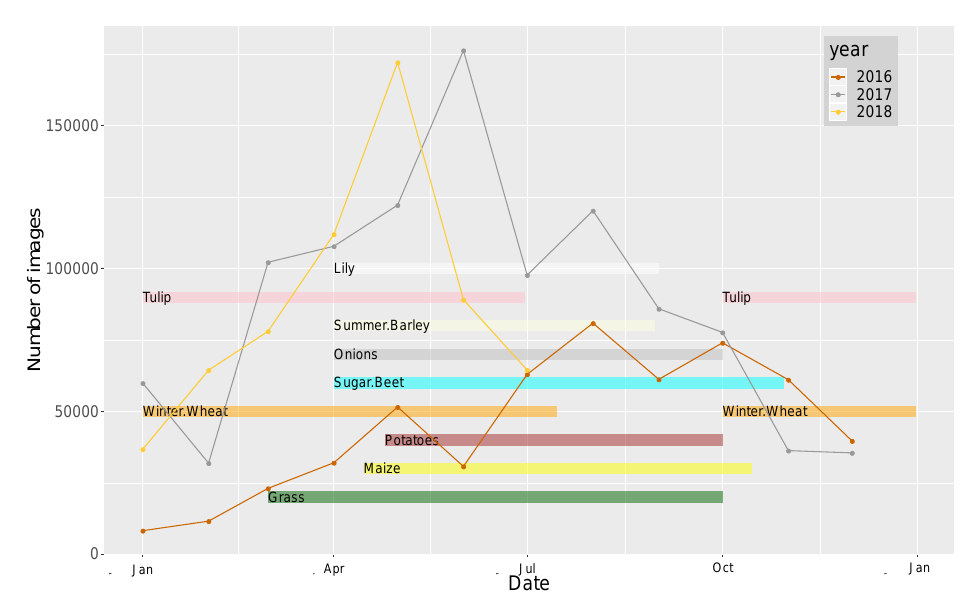
Figure 10. Monthly availability of images throughout the year for 2016–2018 along with growing season of the main